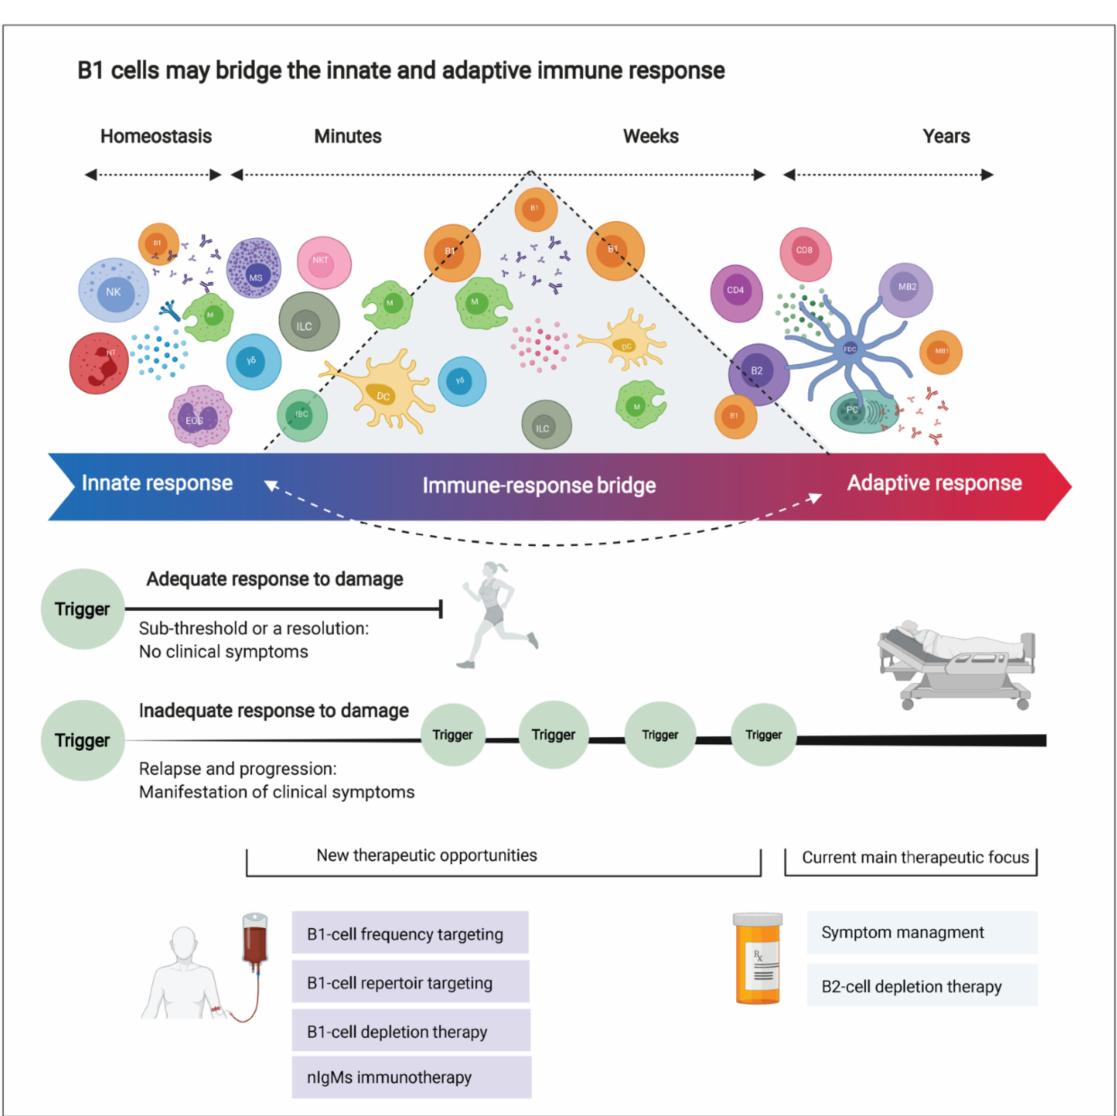
Figure 6. B1 cells may bridge the innate and adaptive immune response, and future therapeutic strategies for multiple sclerosis (MS). Innate immune cells are distributed in the brain to react against damage rapidly. On the other hand, adaptive immune cells reside in lymph nodes (mainly outside the central nervous system; CNS) and function as highly specialized cells providing antigen-specific, robust, yet slow-to-react immune response. Here, we question this binary division as new evidence points out the blurred lines between the innate and adaptive immune response. The immune response is a continuous, bidirectional, elastic spectrum of defense mechanisms rather than a binary division into “innate” or “adaptive” immune responses. This elasticity might be impaired in MS (and possibly in other CNS-degenerative diseases) due to dysregulation or aberrant functioning of specialized “bridging” cells such as the B1 cell. In aging and MS, the dysregulated B1-cell compartment can disturb the delicate balance between damage and repair in the